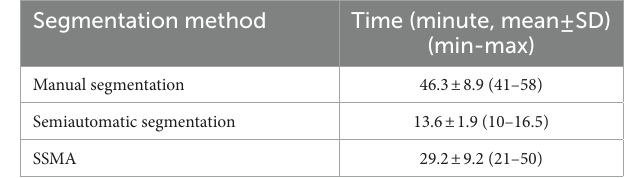
TABLE 2 Measurement time for each method.